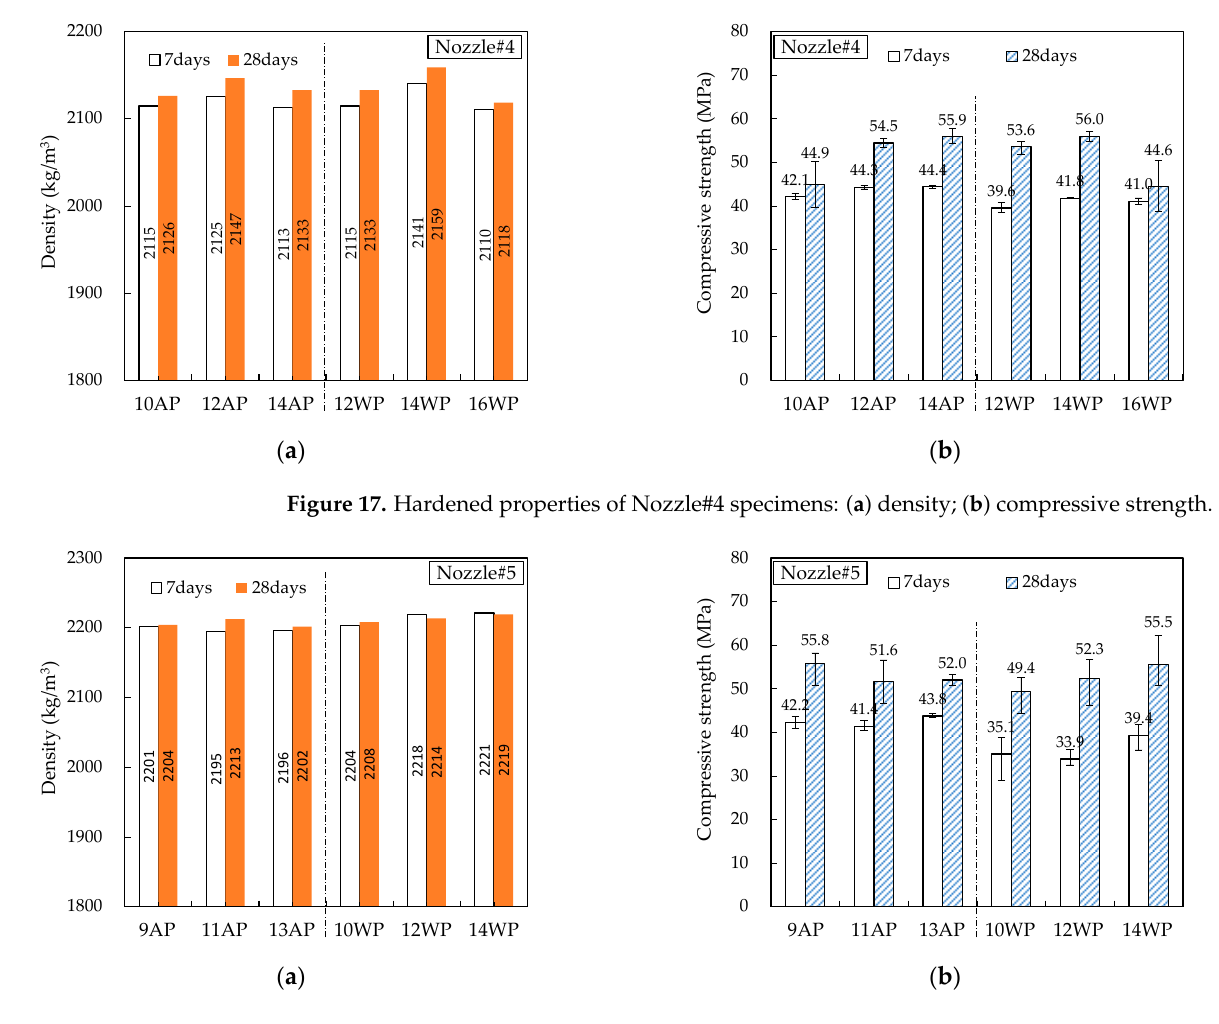
Figure 18. Hardened properties of Nozzle#5 specimens: ( a ) density; ( b ) compressive strength. In almost all specimens, the density increased with increasing age. The additional production of hydrates by the hydration reaction apparently contributed to the density increase. The density of the WP specimen was slightly lower than that of the AP specimen because the cohesion between the cement paste particles was reduced and loosened owing